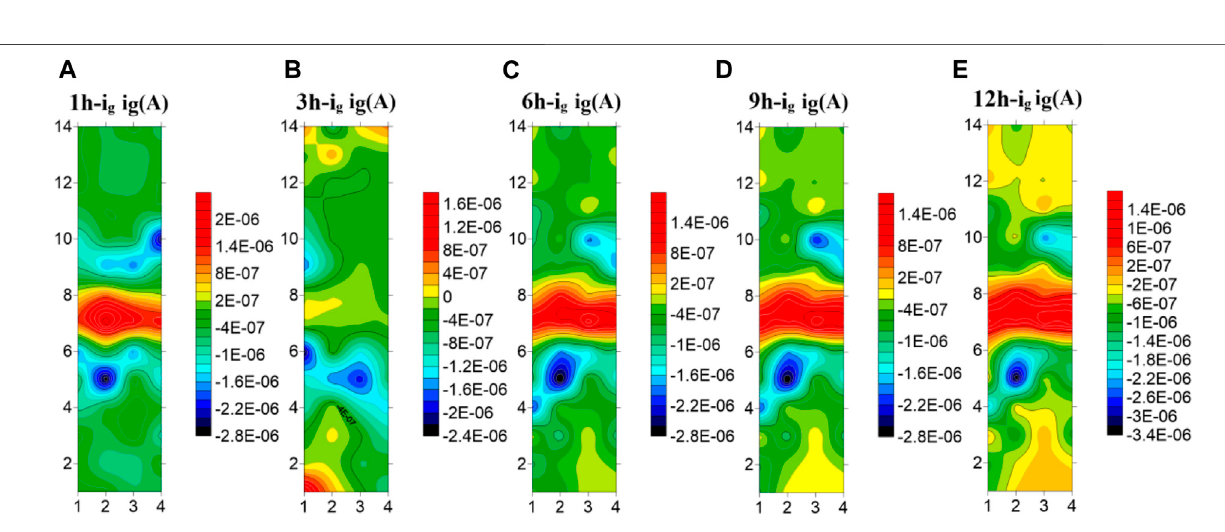
Frontiers in Chemistry |